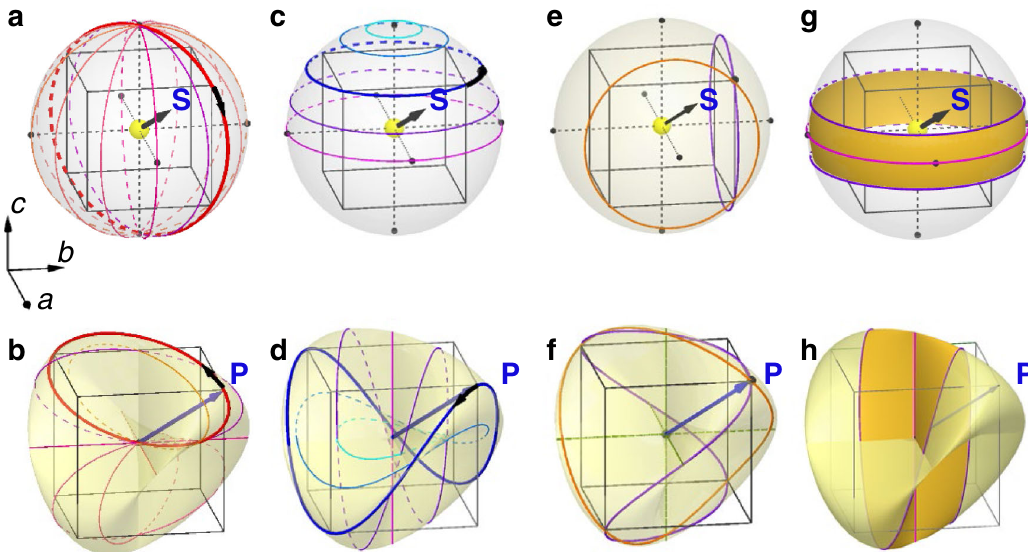
Fig. 4 Various loops on a sphere of Néel vectors (top panels) and the induced fundamental polarization trajectories on Roman surface (bottom panels). a Longitudinal ( fi xed φ ) path of the Néel vector rotation mode with a series of selected φ values and continuously varying θ 2 0 ; 2 π ½ b Trajectories of P induced by loops in a with the same color. c Latitudinal ( fi xed θ ) Néel vector rotation mode with a series of selected θ values and continuously varying φ 2 (cid:2) π ; π